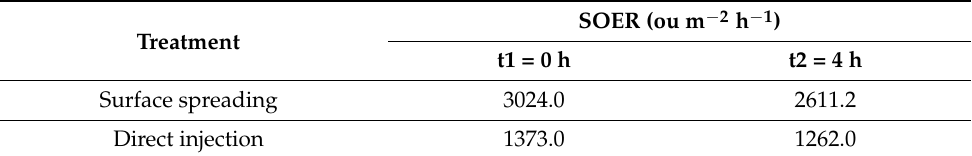
Table 1. Odour emission measurements at the moment of digestate application (t1) and after 4 h (t2) for the two studied application